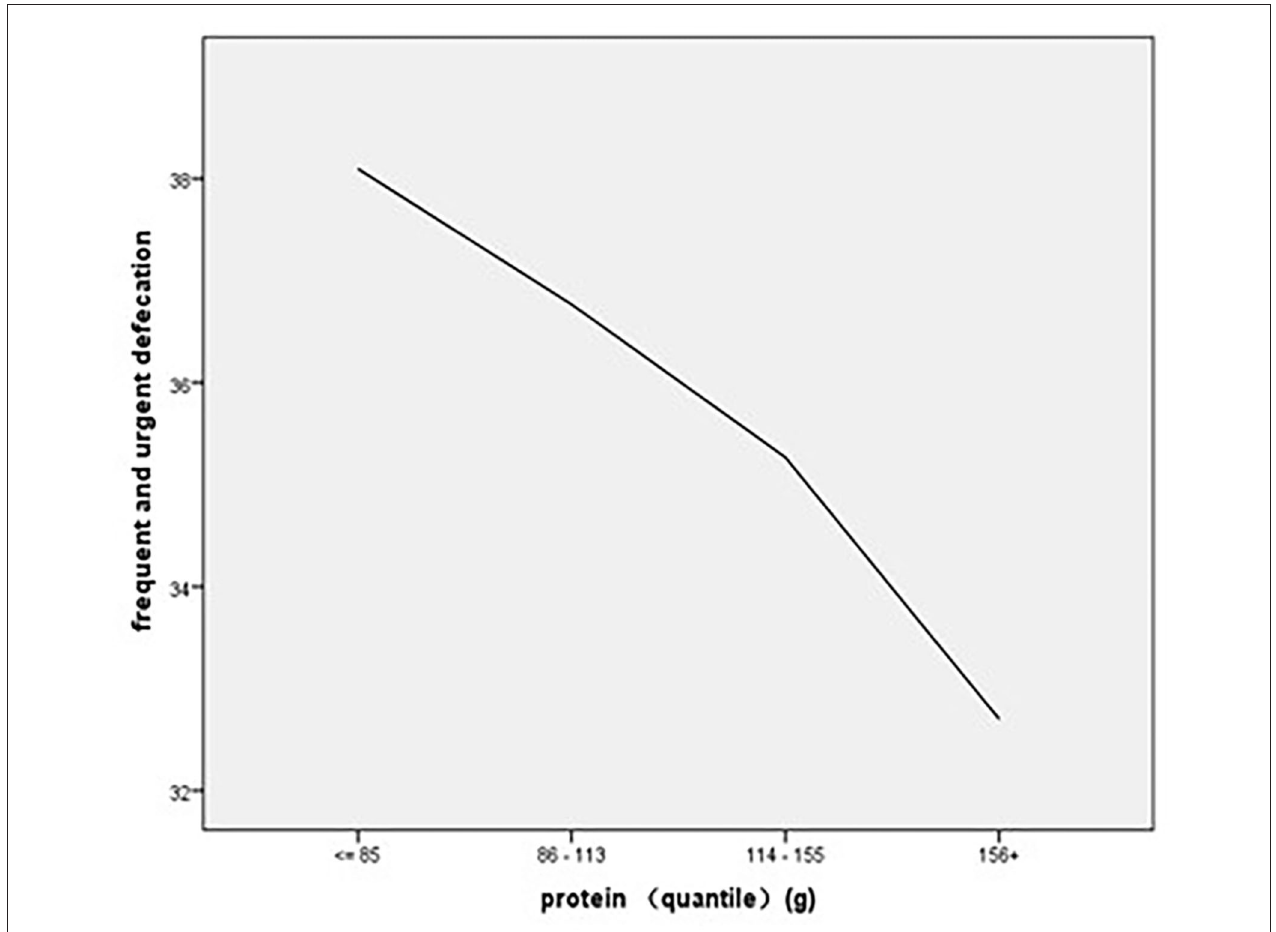
FIGURE 4 | The association of stratified quintiles of consumption of protein with frequent and urgent defecation.